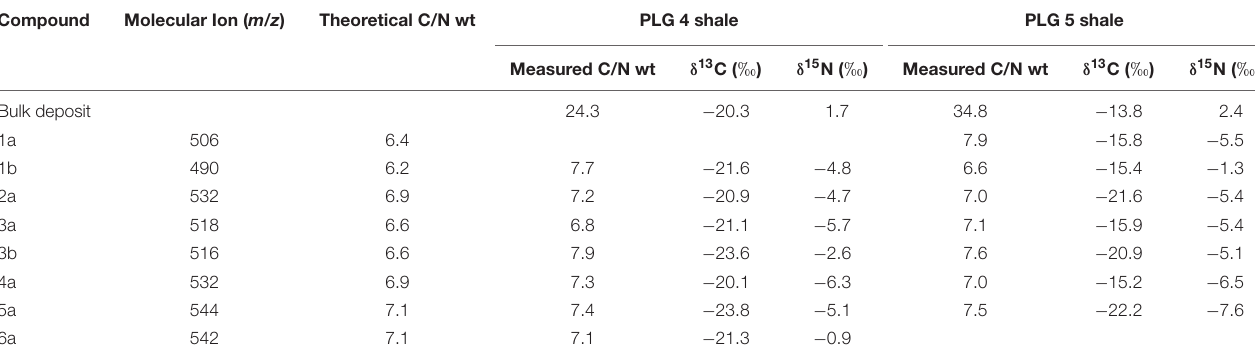
Names of the compounds refer to individual porphyrins indicated in Figure 2 . The analytical precisions for the porphyrin isotopic measurements were within ±